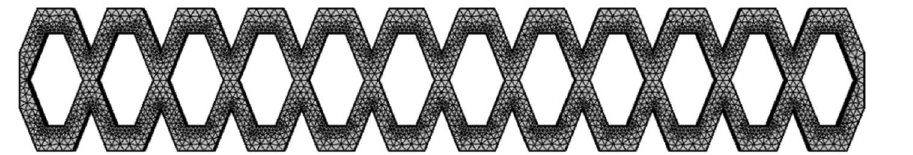
Figure 4. The grid division of emitter flow channel structure.